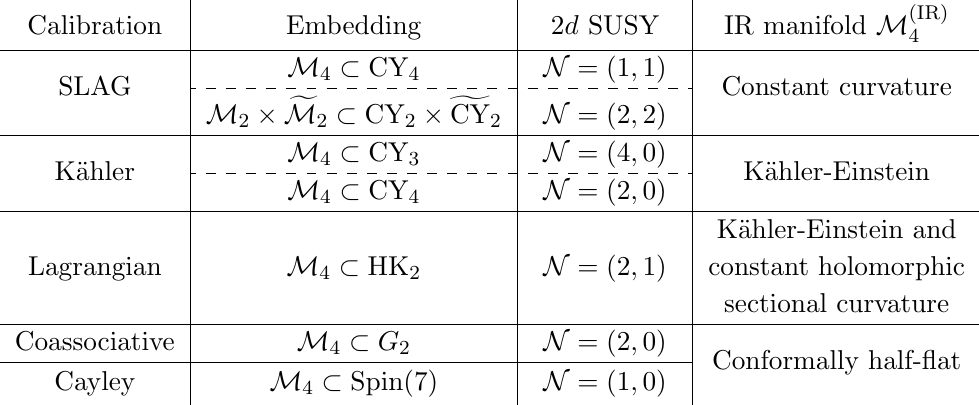
Table 1 . The possible calibrated four-cycles of special holonomy manifolds (coming from bilinears of spinors). In the (cid:12)rst two columns we list the type of calibration and the particular embedding into the special holonomy manifold. In the third column we write down the maximal supersymmetry preserved in the two-dimensional superconformal (cid:12)eld theory from the respective calibration (or from the equivalent partial topological twist). Finally, in the fourth column we list the conditions arising from (known) supergravity solutions [15{18] on the four-cycles in the infrared limit, where the geometry is given by AdS 3 (cid:2) M (IR)